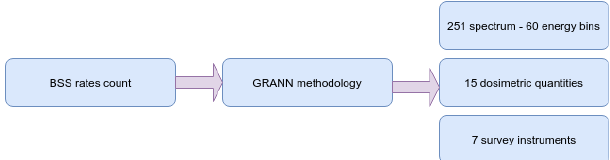
Figure 6. Stage two, neutron spectra unfolding code based on GRANN